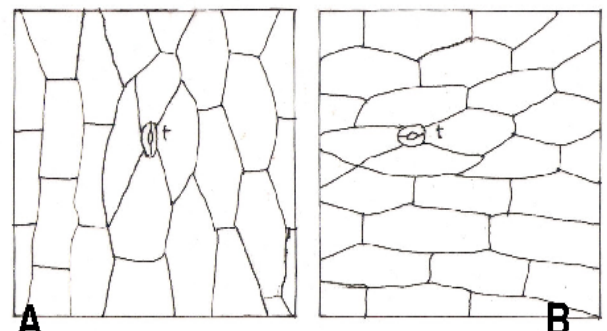
Fig. 2. Surface view of leaf epidermis, abaxial (A) and adaxial